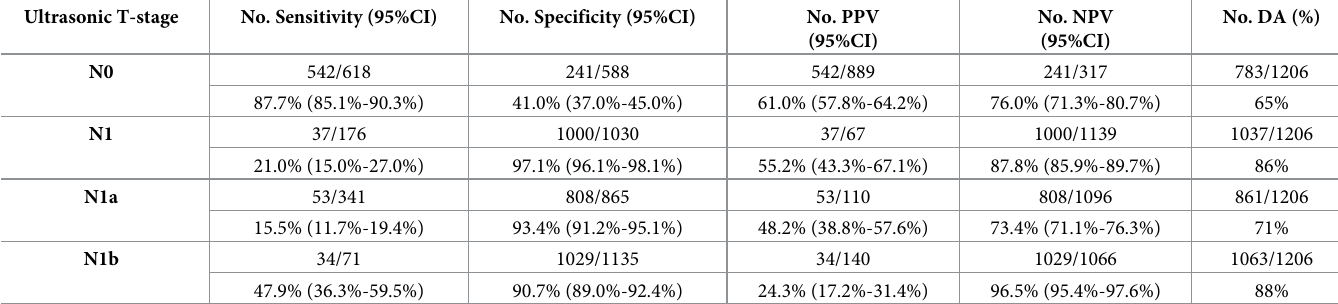
Table 7. The diagnostic value of ultrasonic N-staging compared to pathological N-staging of DTC. Ultrasonic